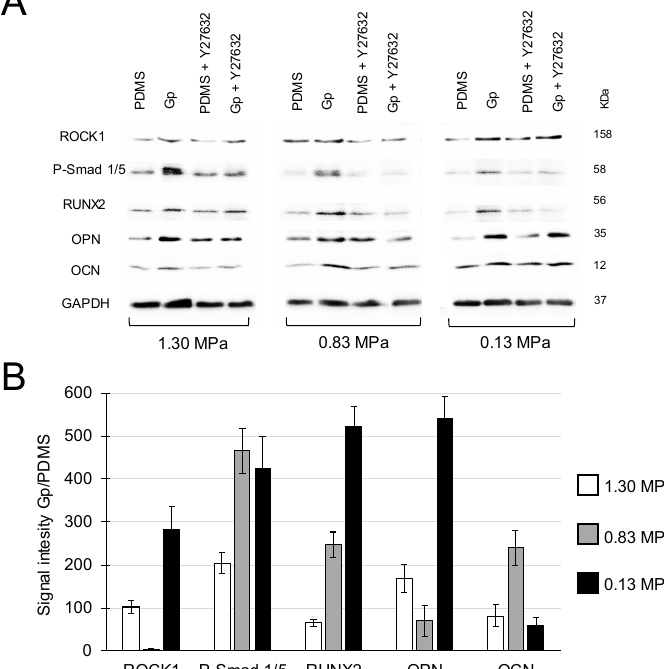
Figure 4. ( A ) Regardless of the stiffness of the underlying substrate (PDMS), Gp upregulated the expression levels of ROCK1, Smad p1/5 and F-actin and bone-related proteins. With the exception of ROCK1/0.83 MPa, Gp increased the expression of all proteins by >50%. ( B ) Relative quantification of all groups in the absence of inhibitors. Signal intensity is in arbitrary units.